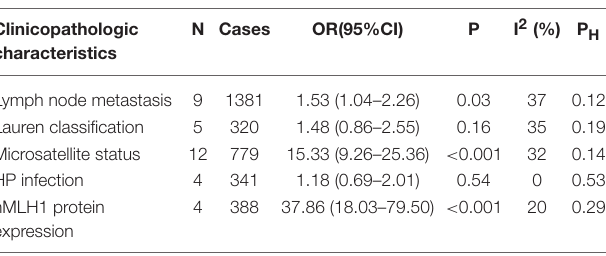
TABLE 3 | The association between hMLH1 promoter methylation and clinicopathological characteristics of gastric cancer. Clinicopathologic